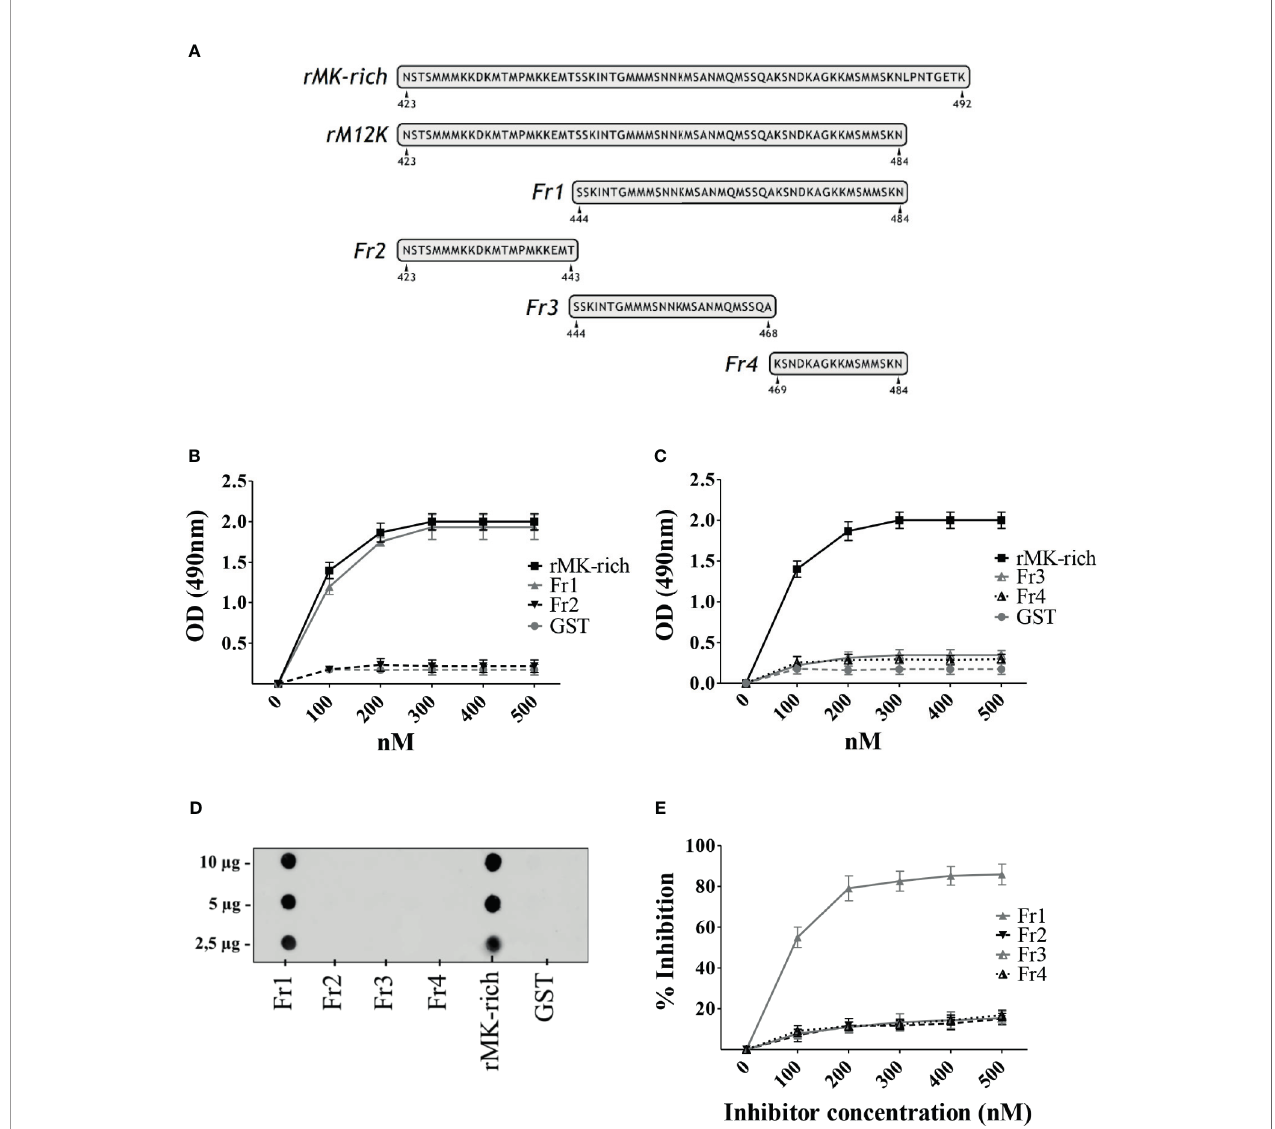
FIGURE 3 | A C-terminal fragment of the MK-rich domain is suf fi cient for binding to Plg. (A) , Schematic representation and sequence of truncated forms of MK-rich domain. (B, C) , Binding of MK-rich and its truncated forms to Plg. Recombinant MK-rich and its derived fragments (250 nM) were immobilized on the surface of microtiter wells, and their binding was tested with increasing concentrations of Plg. Bound Plg was detected with rabbit antibodies to human Plg followed by HRP- conjugated goat anti-rabbit IgG. (D) , Dot blot analysis of MK-rich/fragments-Plg interactions. Increasing concentrations of rMK-rich or its fragments were spotted onto the nitrocellulose membranes and probed using 1 m g of Plg, which were detected using anti ‐ Plg antibodies. GST was used as negative control. Shown are data from one representative experiment of two producing similar results. (E) , Selective inhibition of MK-rich-Plg interactions. Competitive ELISA assays were done with immobilized rMK-rich (250 nM) to which Plg (100 nM) was added in the presence of increasing concentrations of Fr1, Fr2, Fr3 and Fr4. Inhibition ability is shown as percentage. Data are means ± SD from three independent experiments conducted in